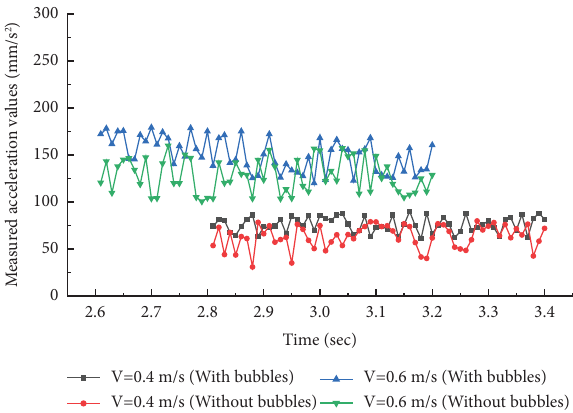
Figure 13: Diagram of the measured acceleration